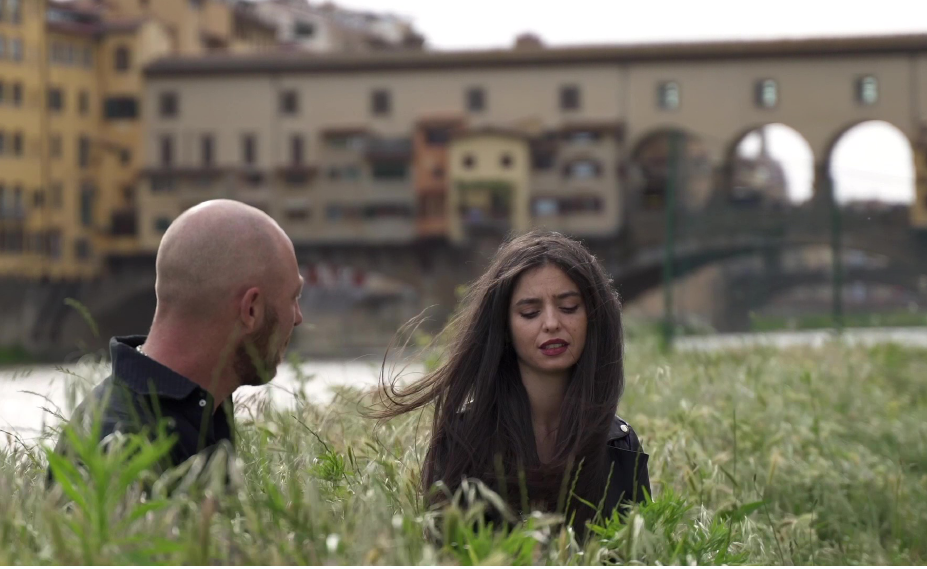
Fig. 3 F. Pinzani and a